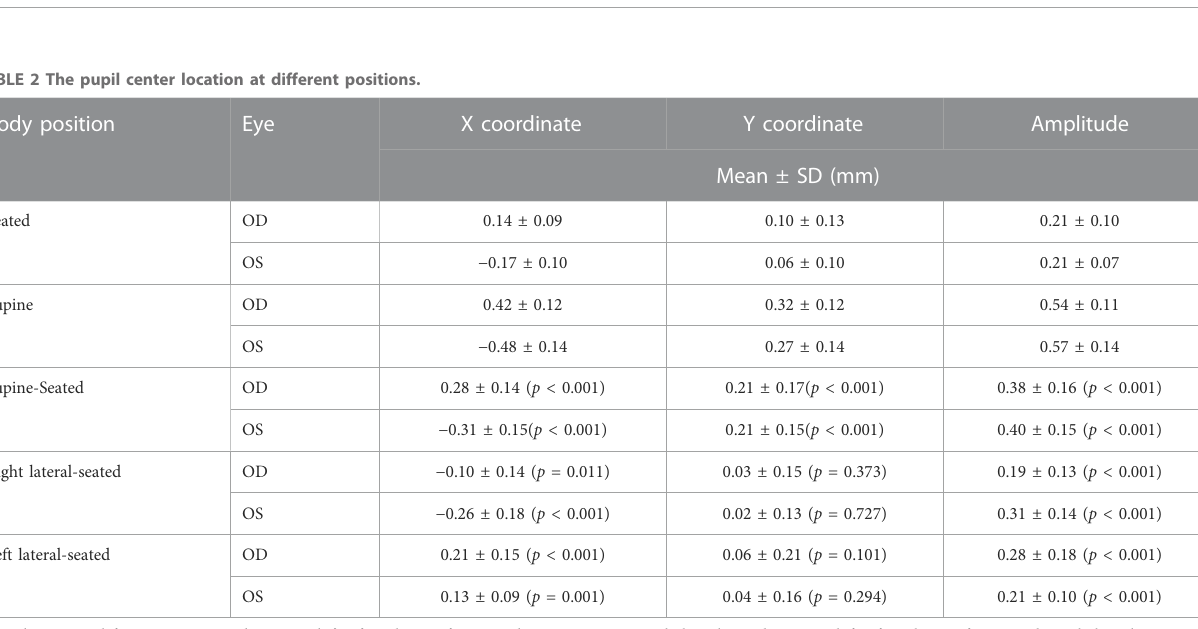
FIGURE 3 The pupil center location at seated and supine positions. (A) shows right eyes, and (B) shows left eyes. The coordinates (0, 0) represent the limbus center. The pupil center location of both eyes located slight superiorly and nasally, which shift more superiorly and nasally at supine position. Temporal, superior, inferior and nasal represent the direction of both eyes.